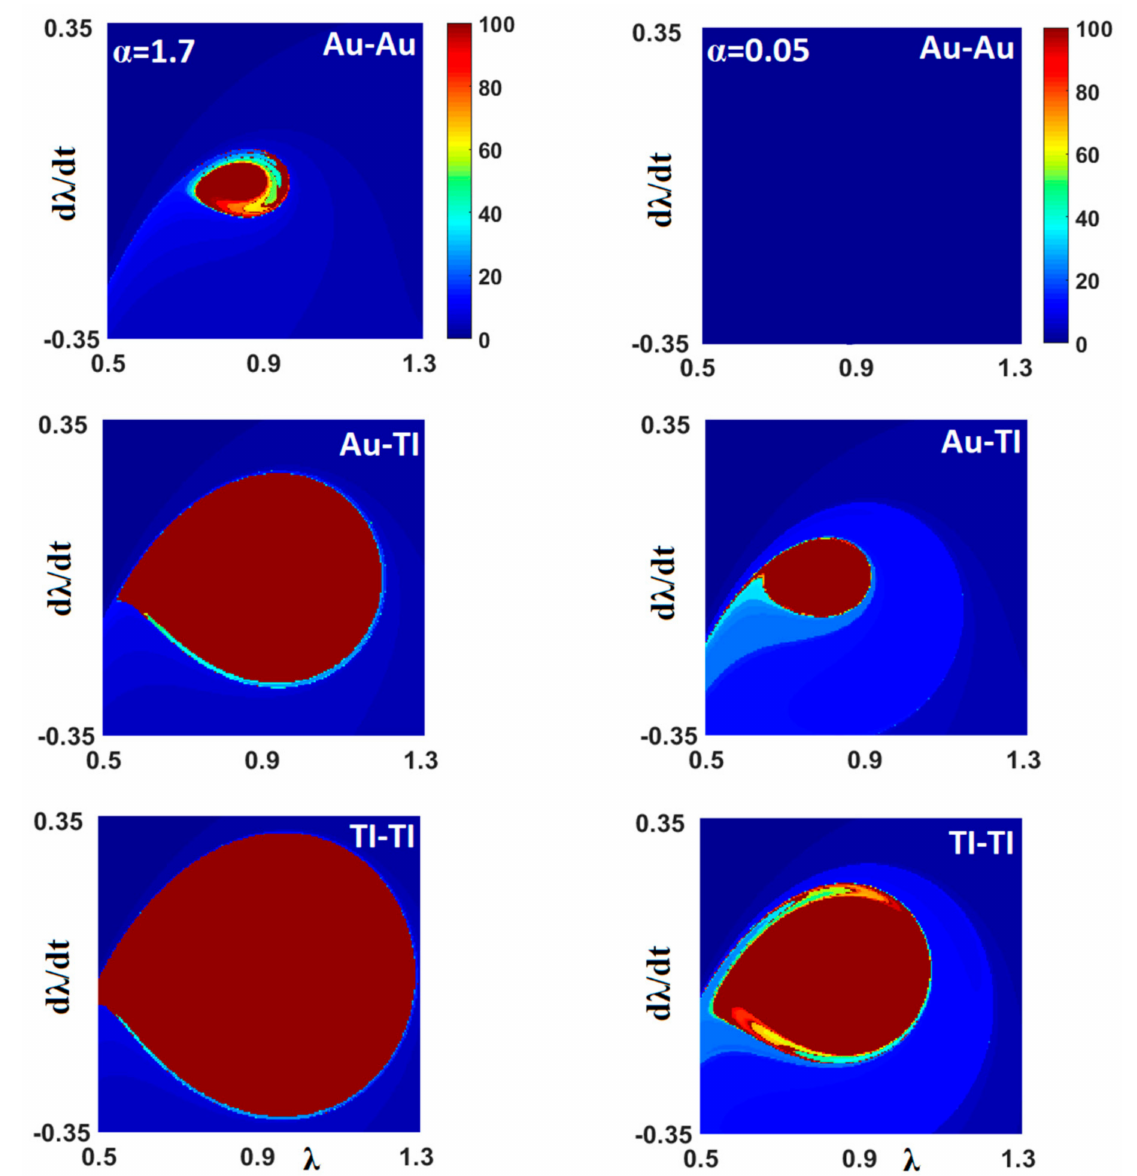
Figure 7. Contour plot of the transient times to stiction in the phase plane d λ /dt vs. λ for systems made of different pairs of materials. The initial distance be 1000 nm, ω / ω o = 0.5, and δ Cas = 0.031. The parameter α is indicated in the plots for both columns. For the calculations, we used 150 × 150 initial conditions ( λ , d λ